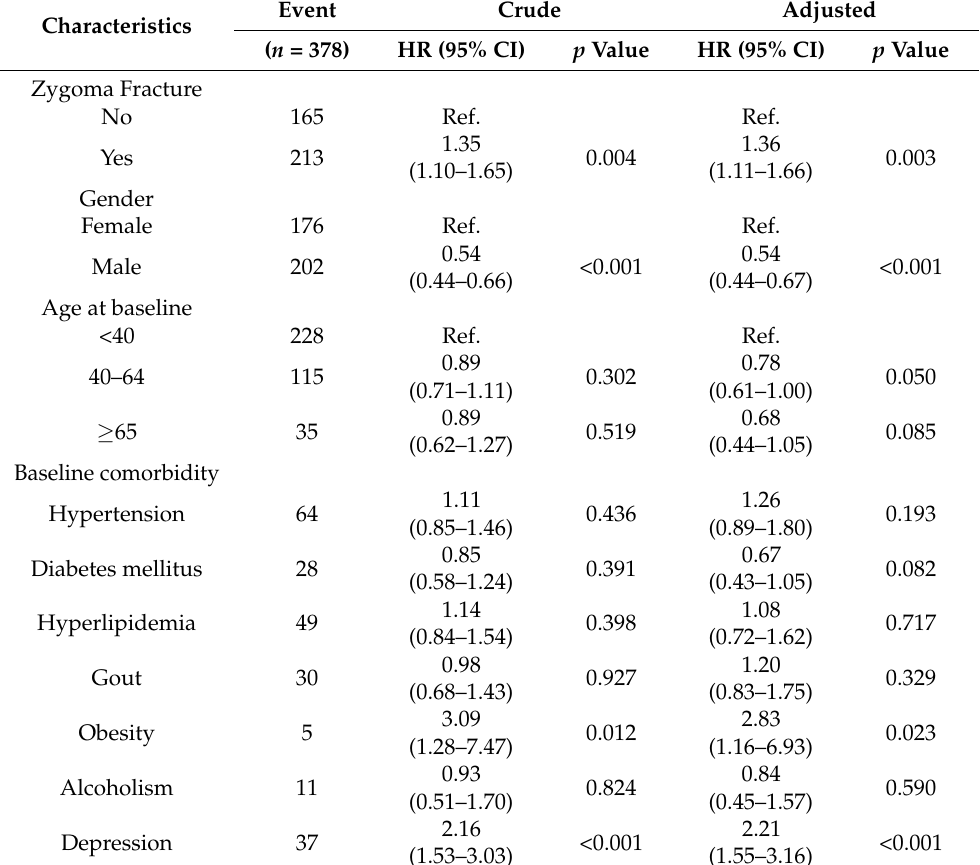
Table 2. Cox model measured hazard ratio and 95% confidence intervals of post-traumatic headache associated with and without zygoma fracture.